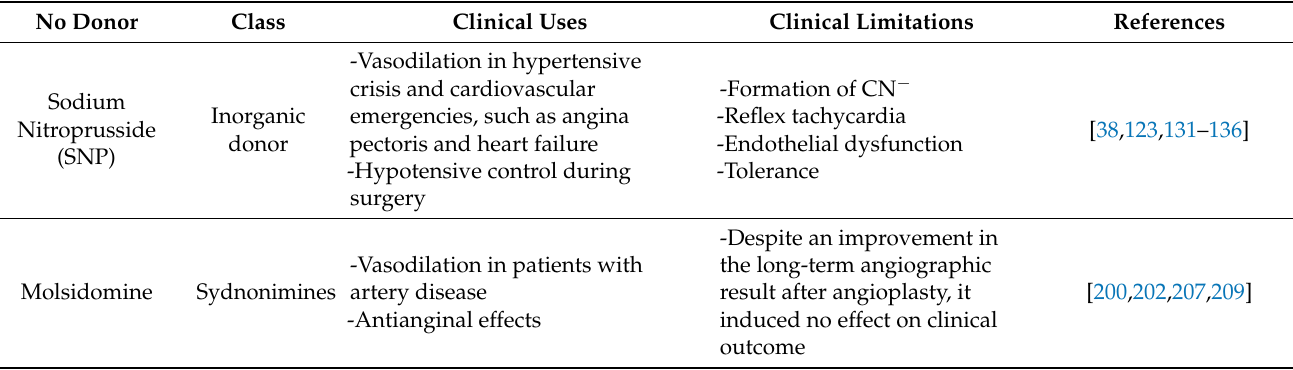
Table 1. Classic NO